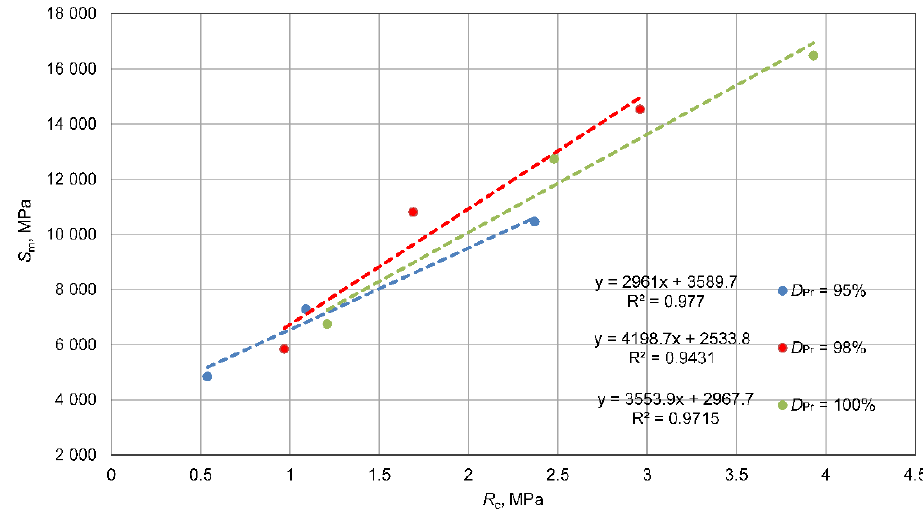
Figure 15. Relationships between unconfined compressive strength, R c , and dynamic stiffness modulus, S m .